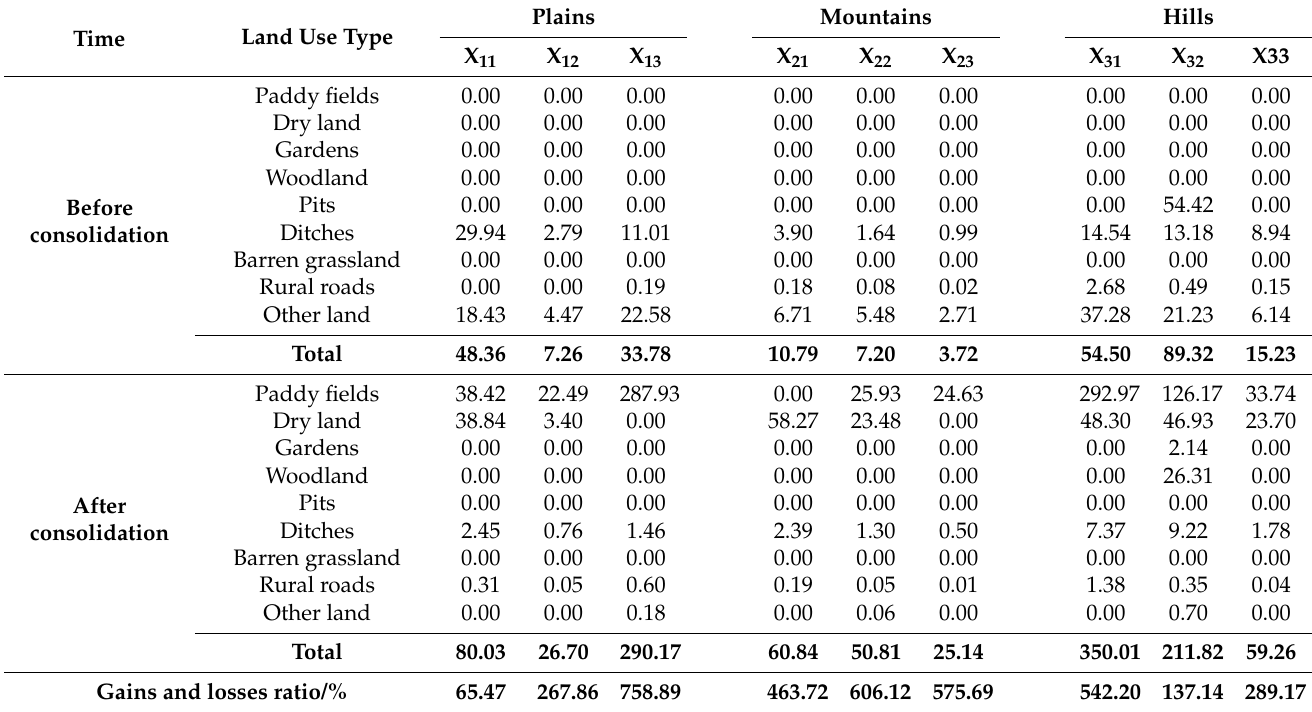
Table 3. Changes in the total amount of ESV before and after consolidation Unit: × 10 3